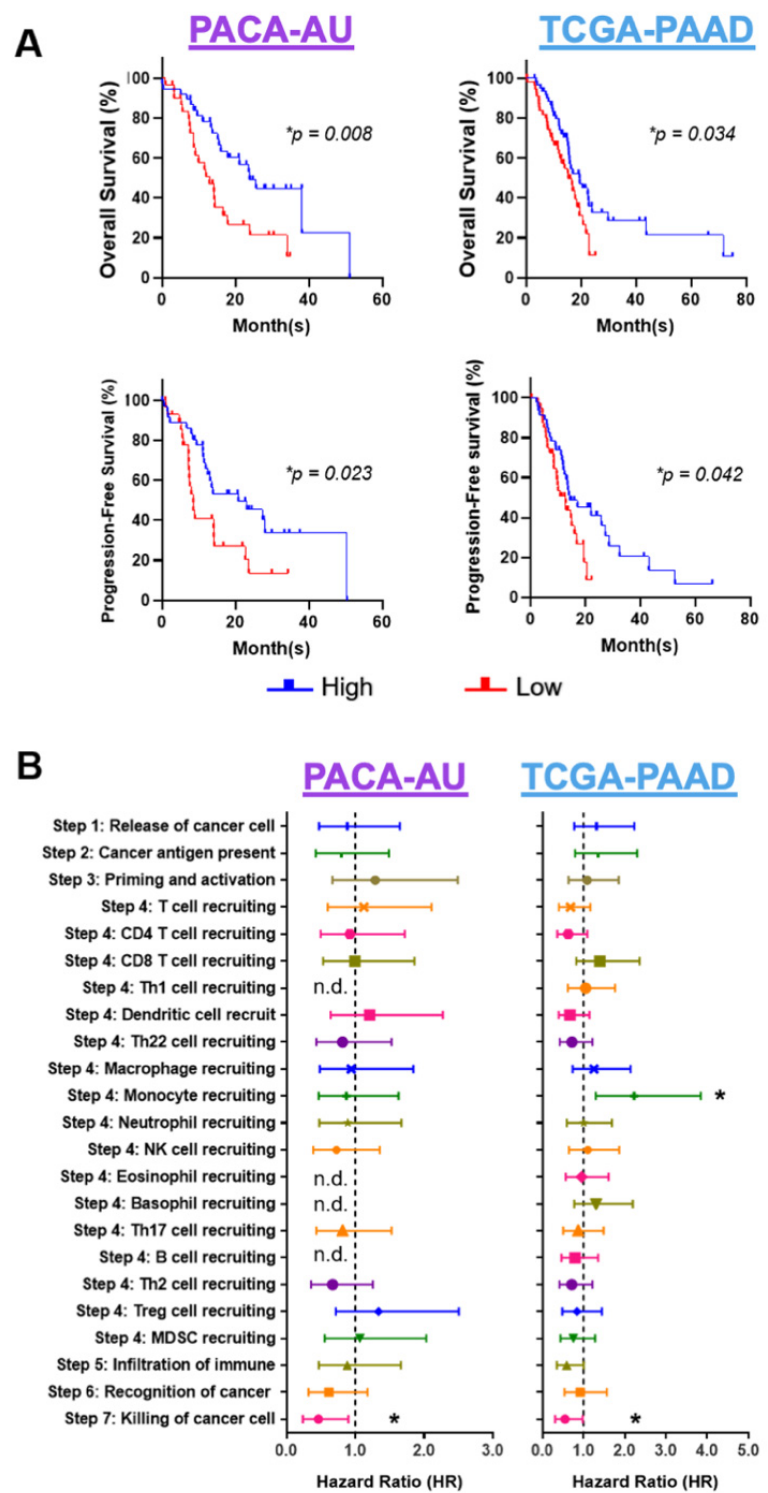
Figure 1. Association of immune activity scores with overall survival. ( A ) High cytotoxic T lymphocytes (CTL) activity (blue line) correlated with better overall survival (OS) and progression-free survival (PFS) in PACA-AU ( n = 69 for both OS and PFS) and TCGA-PAAD cohorts ( n = 119 for OS and n = 89 for PFS) compared to low CTL activity (red line). ( B ) Forest plots of PFS in relation to immune activity score. Asterisks (*) denote statistical significance at p < 0.05; n.d., not determined.